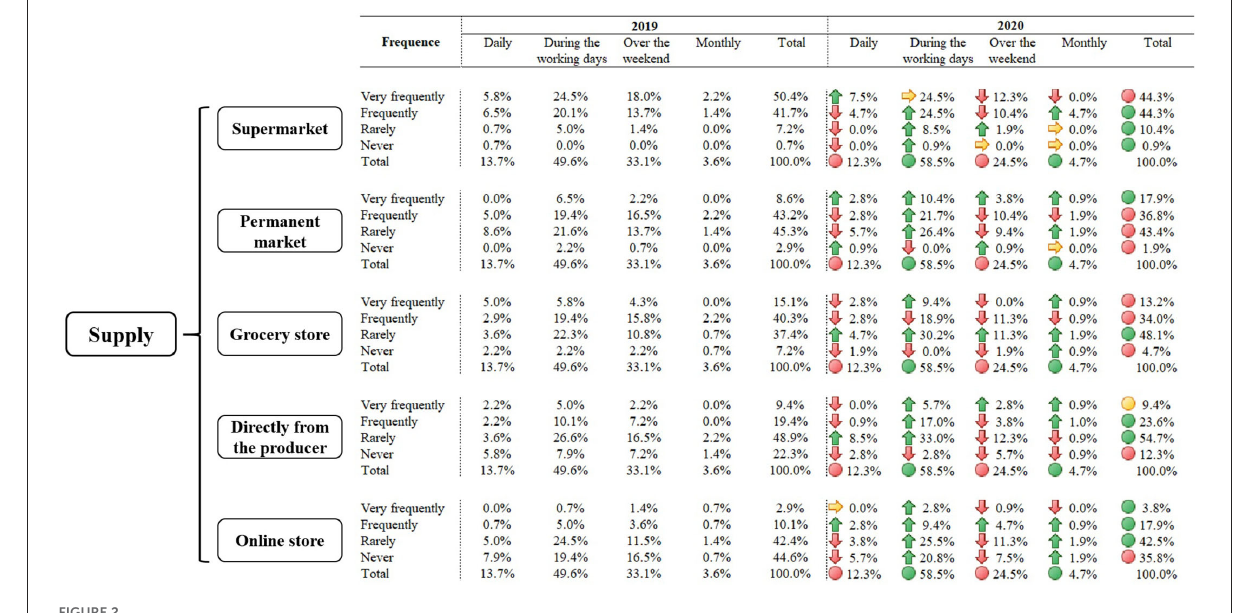
FIGURE2 Shopping patterns in terms of frequency and places of